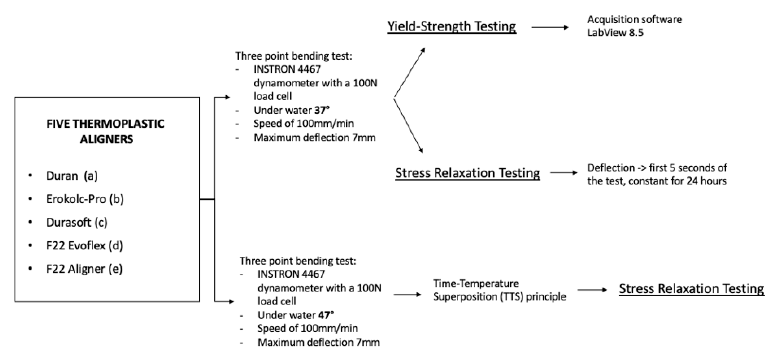
Figure 2. Research flow of the tests employed.